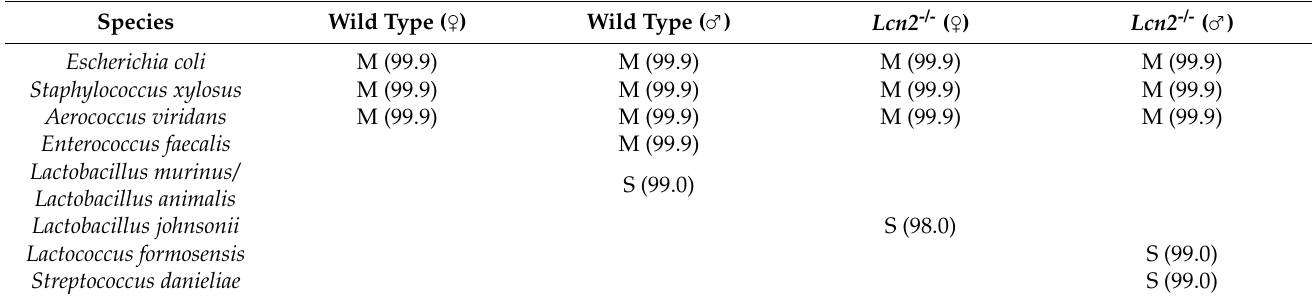
Table 1. Identification of aerobically- and microaerobically-cultured bacterial species from murine fecal samples using MALDI-TOF mass spectrometry and 16S rDNA sequence analysis.